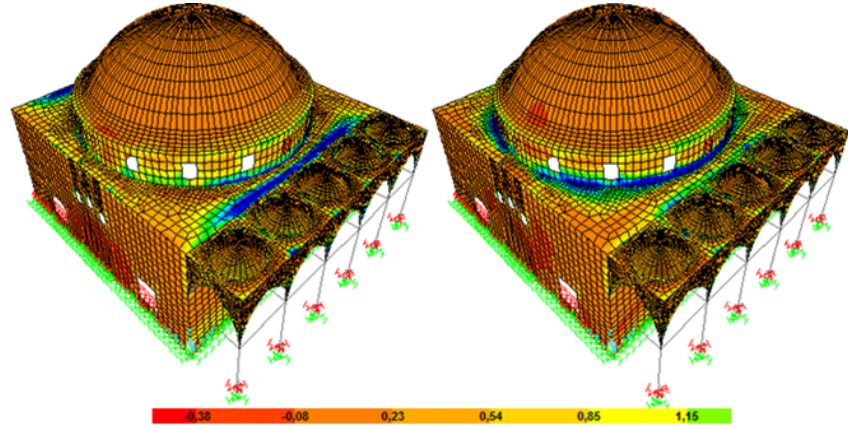
Figure 10. Maximum tensile stresses contour diagram for the outer and inner surfaces of the mosque with 16 window openings under dead load and earthquake load (G + EY).